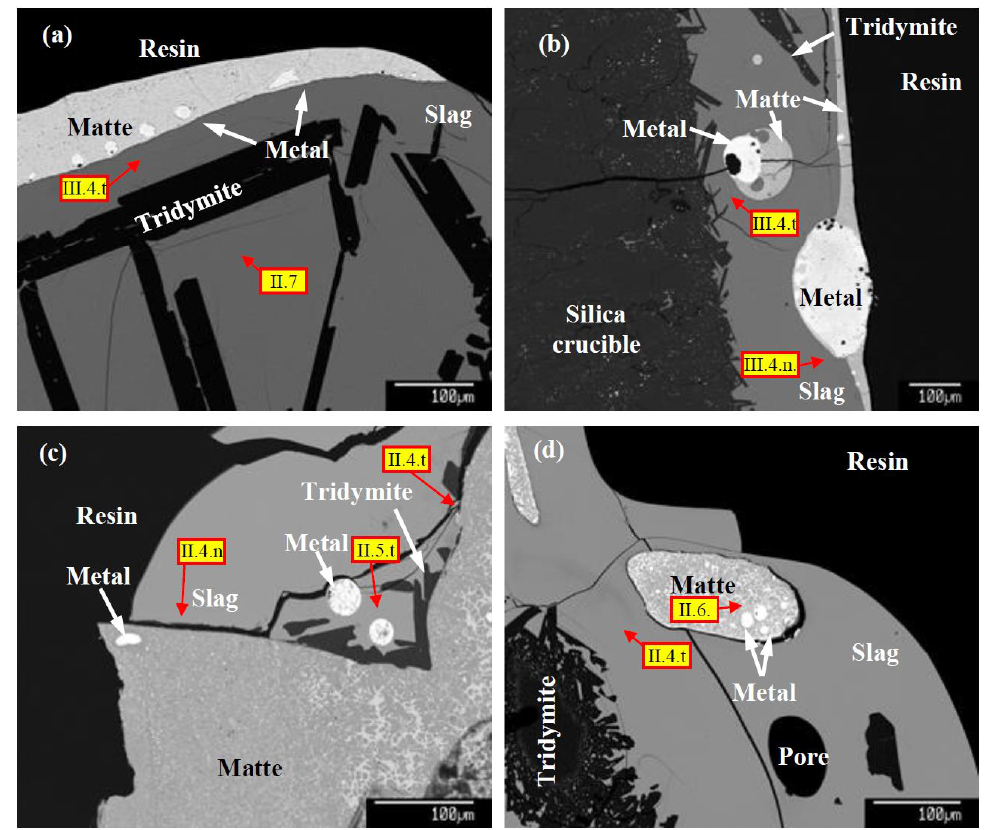
Figure 10. Typical microstructures of preliminary short non-equilibrium experiments investigating the closed slag – matte – Pb metal – tridymite Pb-Fe-O-S-Si system. Table 3. Measured phase compositions for the closed slag – matte-Pb metal – tridymite Pb-Fe-O-S-Si system at 1200 °C with master matte and master slag as starting materials.